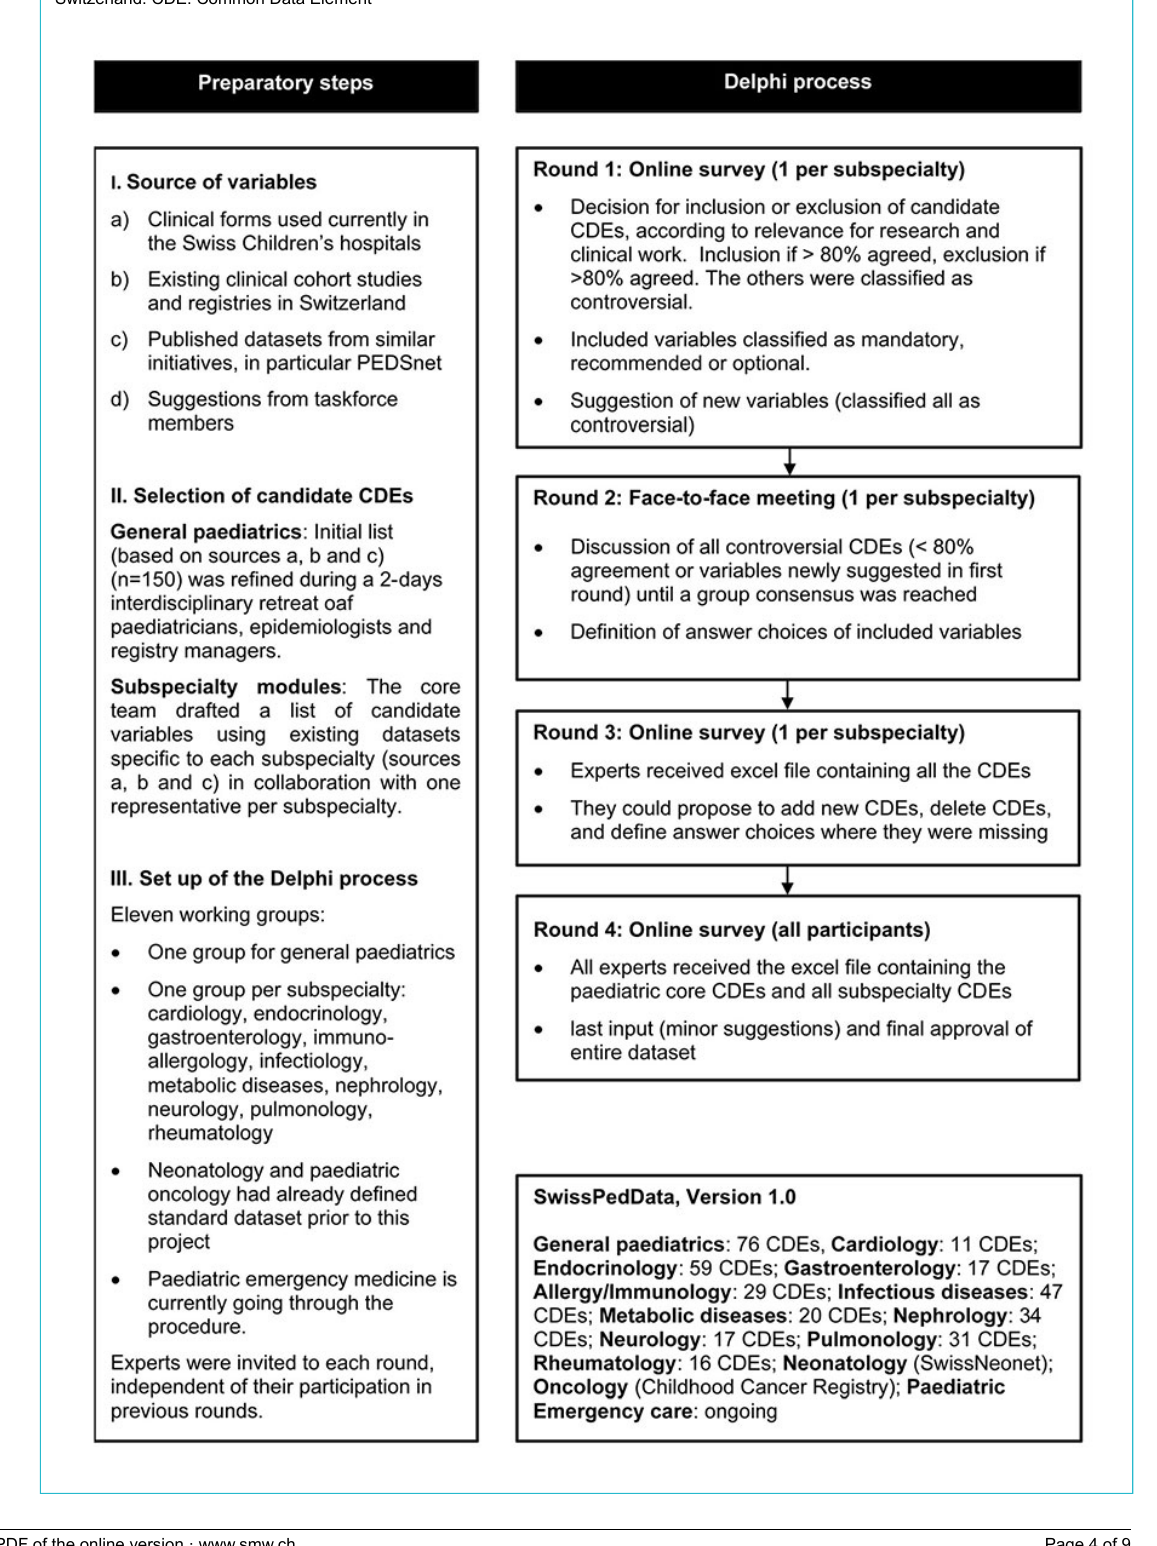
Figure 2: Consensus finding process followed to define SwissPedData, a set of CDEs for recording routine encounters in children’s clinics in Switzerland. CDE: Common Data